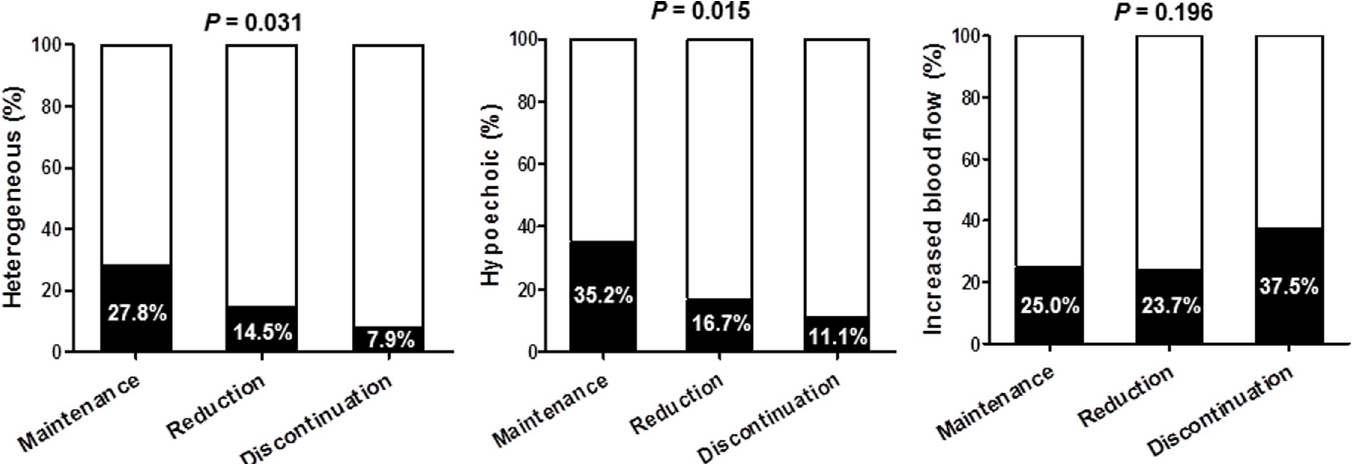
Fig 1. Comparisons of thyroid sonographic findings according to the different outcome groups of L–T4 tapering.